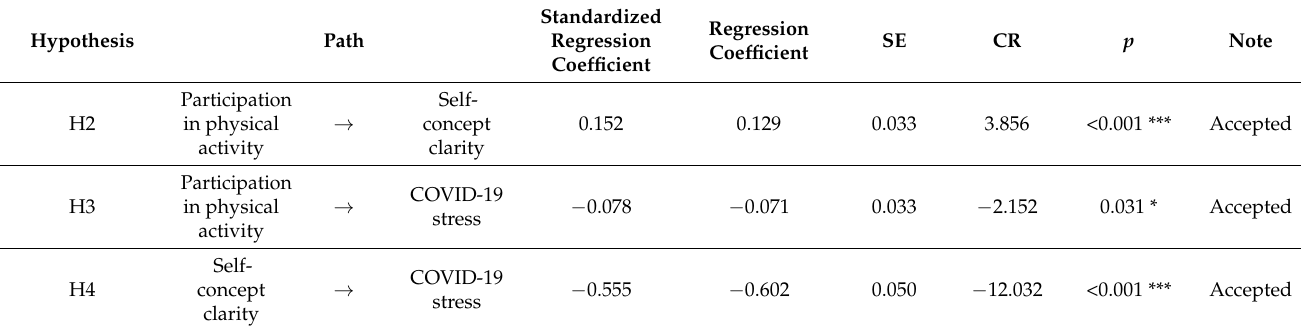
Figure 1. Path analysis model. Table 13. Results of the path analysis.